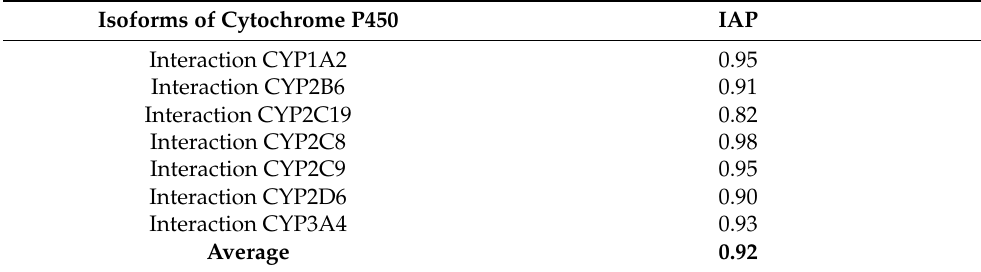
Table 2. Accuracy of the DDIs prediction.